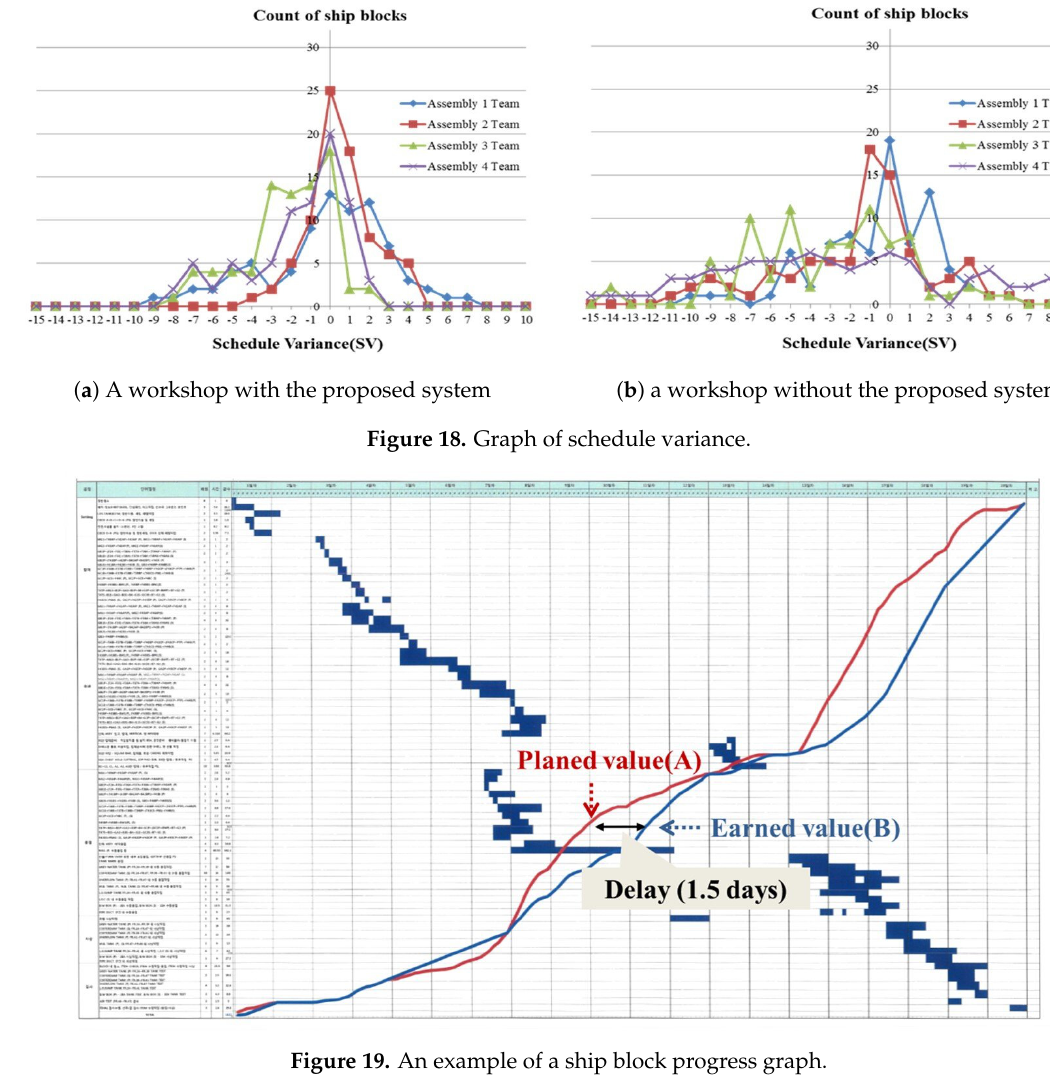
Figure 19. An example of a ship block progress